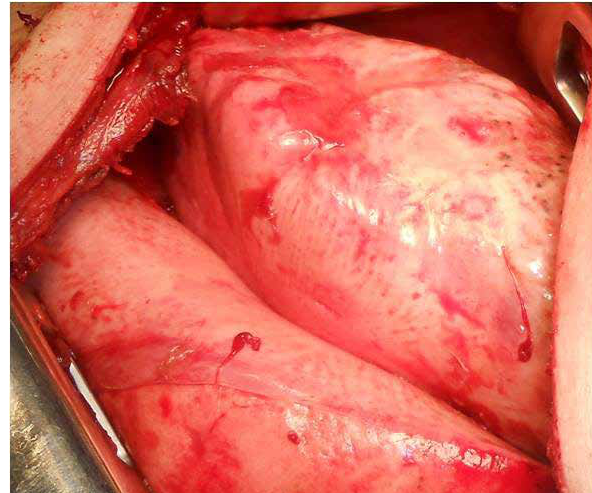
Figure 2: Computed tomography of the chest with I.V. contrast showing left-sided pleural effusion and a likely 3 cm area of active contrast.